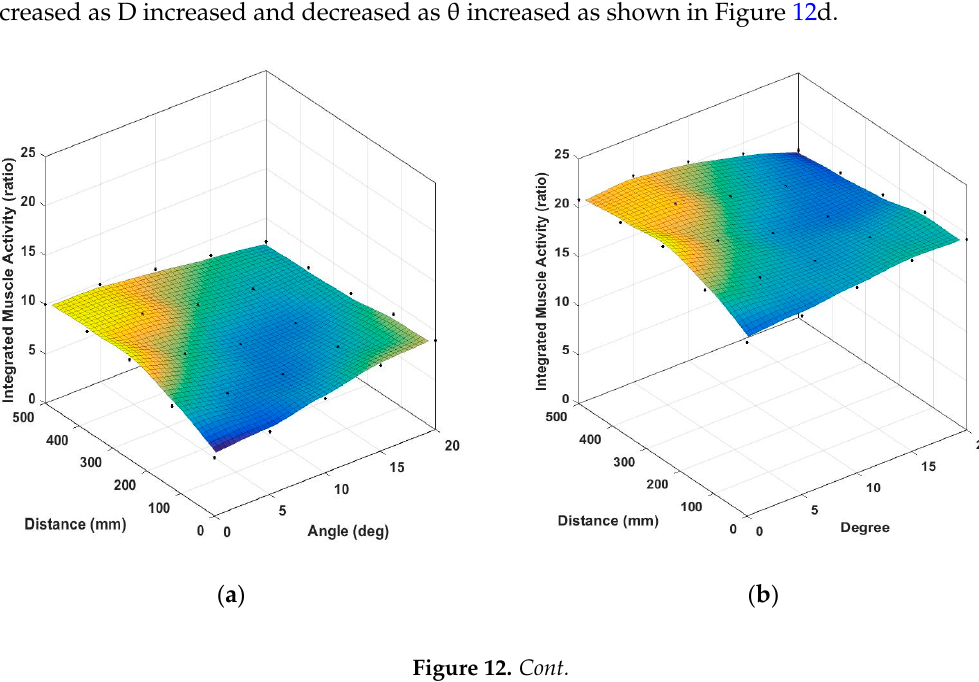
Figure 11. Simulated maximum moments of hip and knee joints for synthesized motions: ( a ) left hip moments and ( b ) right hip moments. ( c ) left knee moments and ( d ) right knee moments. As shown in Figure 11a, the moments of the right and left hip joints were maximum in the case where the foot position (D) was 0.28 h (=500 mm) and guide angle ( θ ) was 0 ◦ and minimum when D = 0.28 h and θ = 20 ◦ from the barbell bar center. The right hip moment decreased as D and θ increased. As shown in Figure 11b, the moments of the right knee joint were maximum when D = 0.21 h and θ = 0 ◦ and minimum when D = 0.28h and θ = 20 ◦ from the barbell bar center. The moments of the right knee decreased as D and θ increased. The average muscle activities of the quadriceps of the right leg during a cycle of squat motion were simulated and plotted for the rectus femoris and vastus lateralis in Figure 12a,b. The patterns of the other quadriceps muscles such as vastus intermedius and vastus medialis are similar to that of the vastus lateralis as illustrated in Figure 12c. The muscle activity increased as D increased in the range of 0 ◦ ≤ θ < 15 ◦ and decreased as D increased in the range of 15 ◦ ≤ θ < 20 ◦ . The muscle activity decreased as θ increased. Exceptionally, the activity increased in the range of 0 ◦ ≤ θ < 5 ◦ and 0.14 h (=250 mm) ≤ D ≤ 0.28 h (=500 mm). The muscle activities of the hamstrings such as the bicep femoris and semitendinosus showed some different pattern from the quadricepts as plotted in Figure 12d. The average muscle activities of the gluteus maximus of the right leg increased as D increased and decreased as θ increased as shown in Figure 12d.